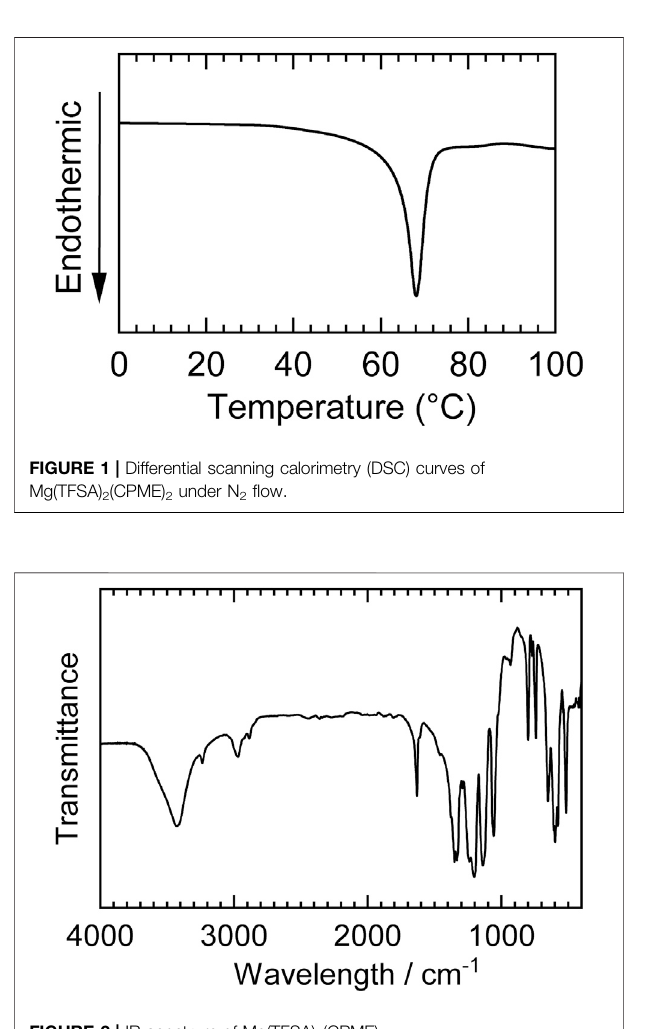
FIGURE 2 | IR spectrum of Mg(TFSA) 2 (CPME) 2 .